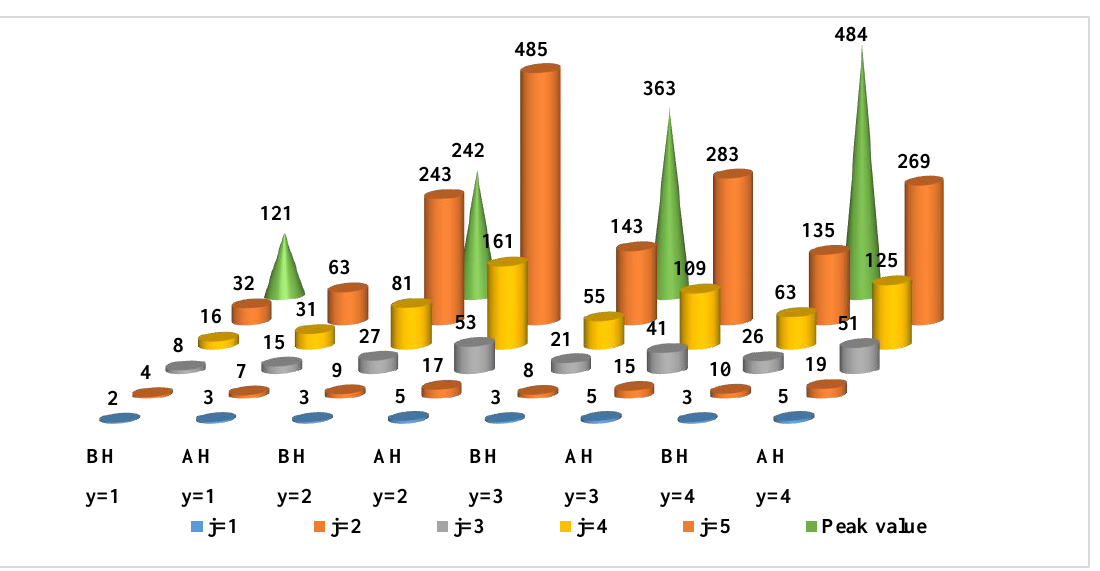
Figure 3. Peak value, variations of the number of levels with respect to ‘y’ (BH-Before H bridge, AH-After H bridge). Table 2. Design procedure to find the value of ‘y’ in a Tri-State Inverter.